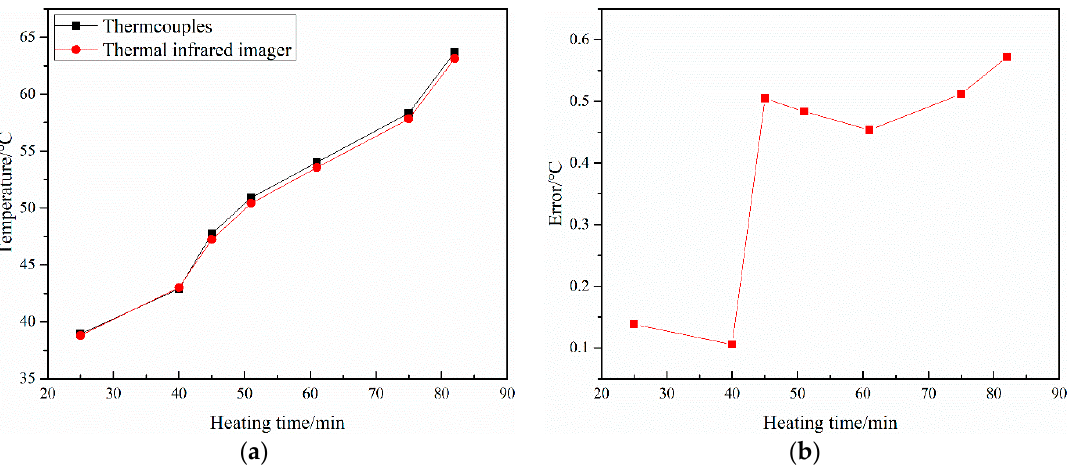
Figure 4. Correction curve of the thermal infrared imager: ( a ) Temperature; ( b ) Temperature error.